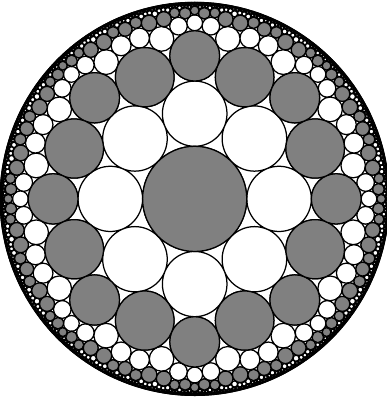
Figure 2.1. A finite portion of the layered circle packing created from the defining sequence { 8,6,8,6, ... } . The circles of degree 8 are